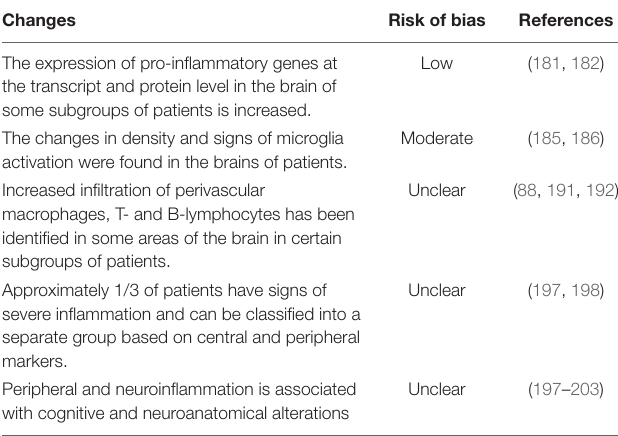
TABLE 7 | Immune-associated changes in the brain of schizophrenia